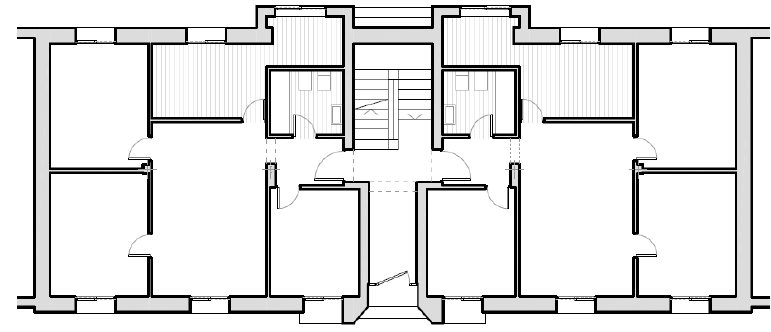
Figure 1. Building plan of the analyzed case study.